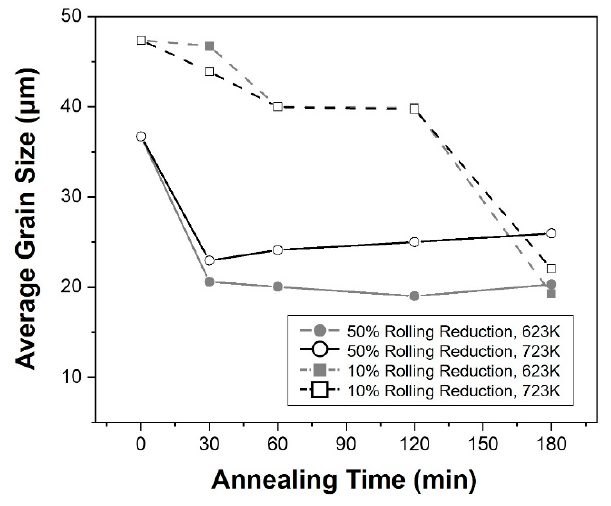
Figure 7. Graph showing the relationship between annealing time and average grain size after rolling with the reduction of 10% and 50%, respectively.